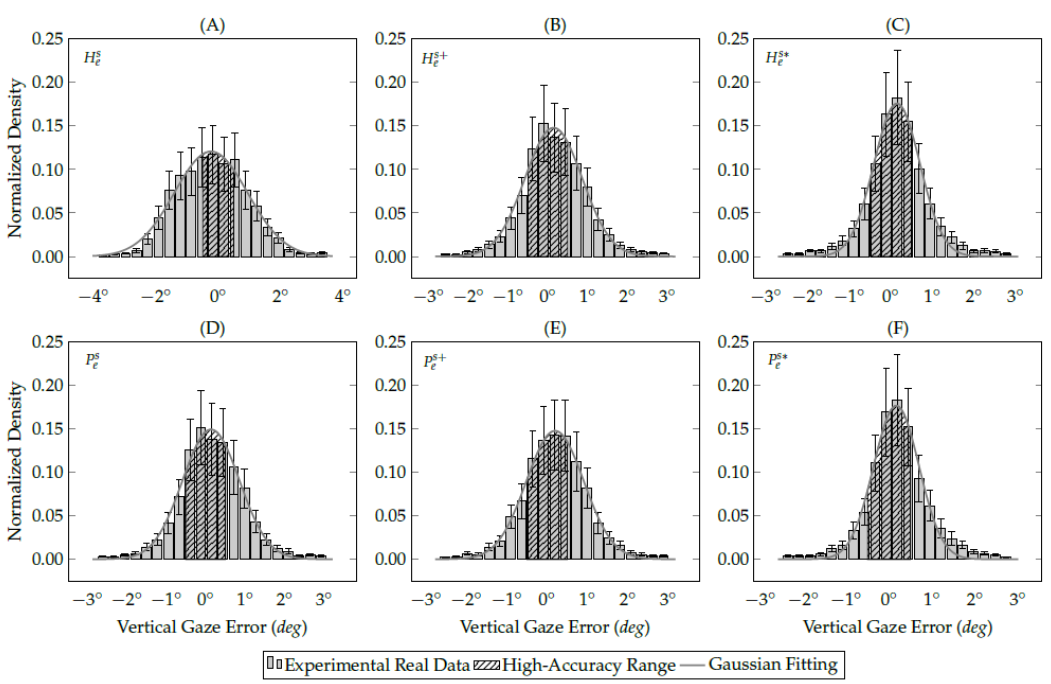
Figure 13. The histograms represent the gaze-error offset on the y -axis (without outliers) of the eye-tracking data collected during the user study. The areas delimited with northeast lines represent the high-accuracy gaze estimation, in which ( A ) traditional homography gaze estimation method achieved 32%; ( B ) homography gaze estimation method with the eye-camera location compensation achieved 50%; ( C ) homography gaze estimation method with both camera location and distortion compensations achieved 62%; ( D ) traditional polynomial gaze estimation method achieved 50%; ( E ) polynomial gaze estimation method with the eye-camera location compensation achieved 50%; ( F ) polynomial gaze estimation method with both camera location and distortion compensations achieved